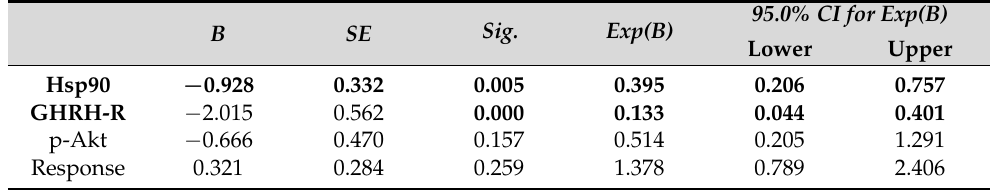
Table 5. Markers showing significant results after the Cox regression analysis of the investigated biological and clinical parameters.